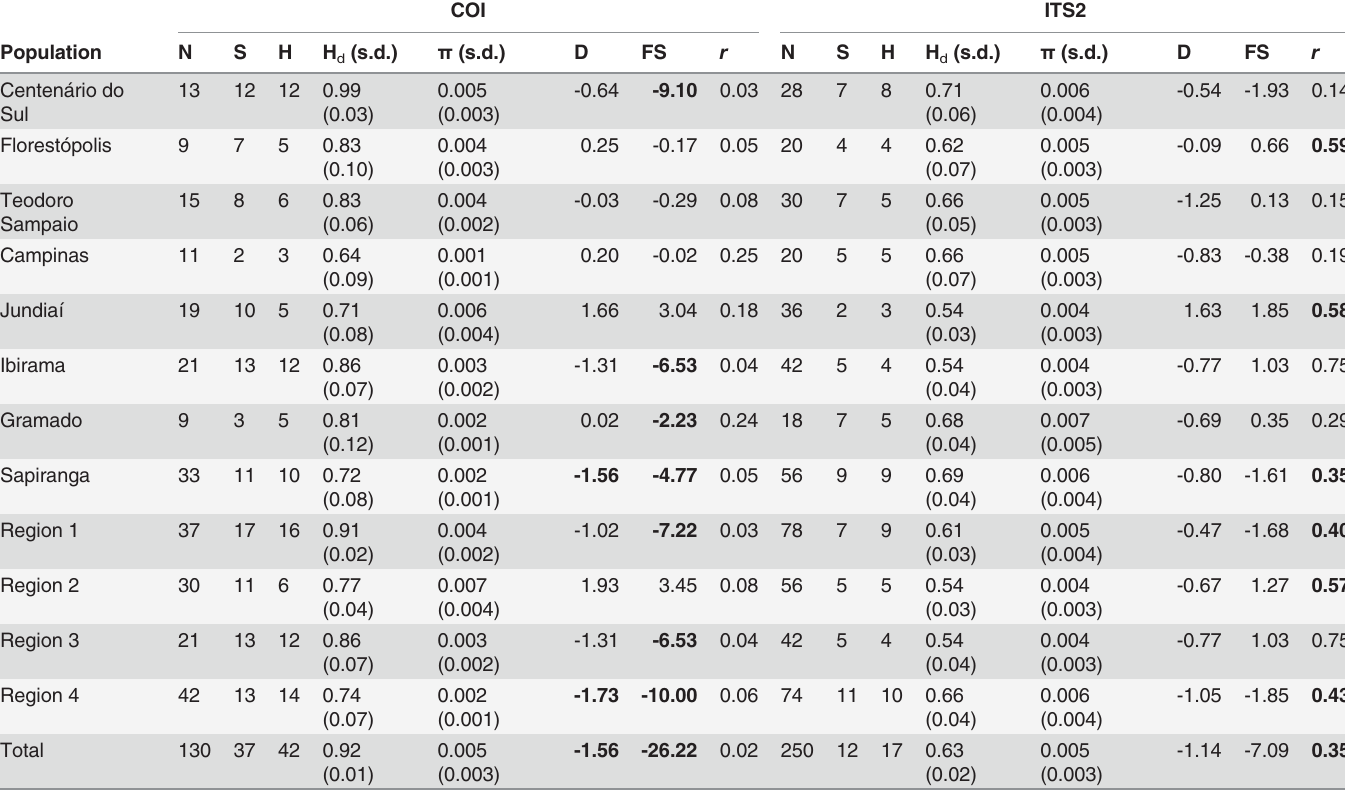
Table 2. Diversity indices, neutrality tests and results of mismatch distribution analyses for populations and geographical regions.